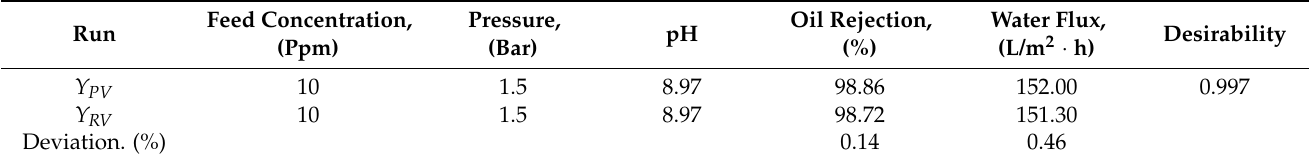
Table 5. Oil rejection and water flux at the optimized condition and corresponding values.